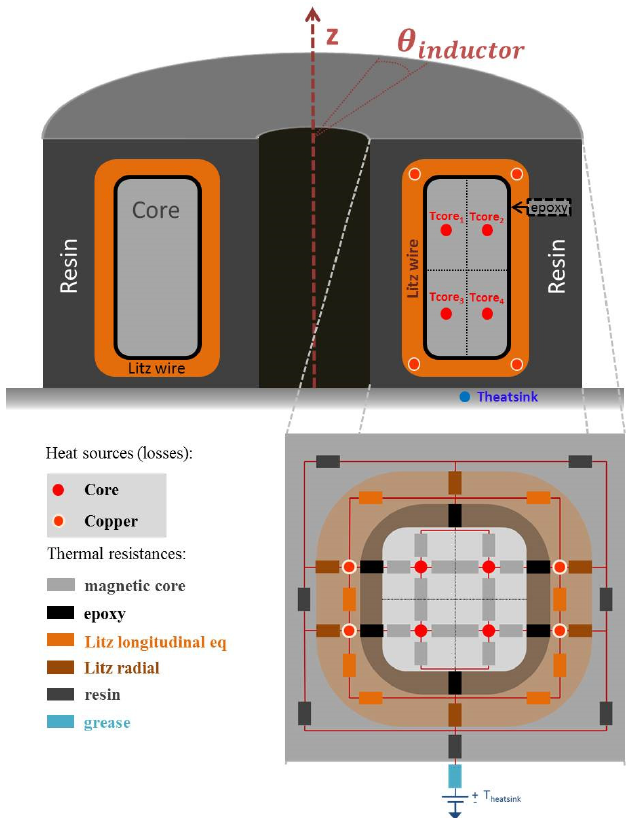
Figure 9. Two-dimensional thermal model of the toroidal phase inductor.